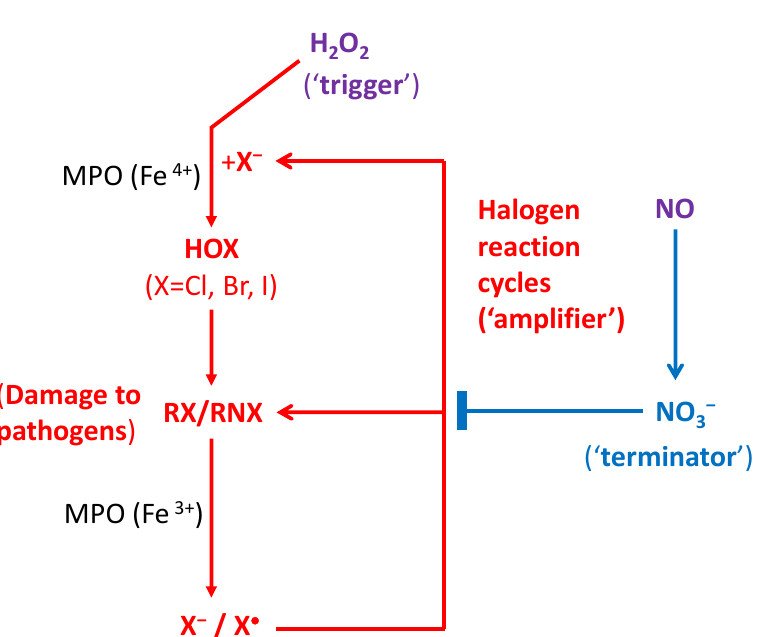
Figure 2. Proposed halogen reaction cycles involved in the immune defense against pathogens and in the inflammatory process. The amplified reactions of reactive halogen species (RHS), including HOX, OX − , X 2 , X • and OX • (X = Cl, Br or I), produced by dissociative electron transfer (DET) within the phagosome cause major damage (represented by RX / RNX) to the DNA / RNA / lipids / proteins of phagocytosed pathogens. The immune defence system consists mainly of three components: the H 2 O 2 signaling pathway as the trigger, the RHS reaction cycles as the amplifier, and the NO • signaling pathway as the terminator. H 2 O 2 from other intracellular organelles such as mitochondria and peroxisomes can also di ff use across membranes and promote the anti-pathogen activity. Table 1. Approximate rate constants (M –1 s –1 ) for aqueous-phase reactions of some species involved in phagocytosis at pH = 7.0, 288 K.